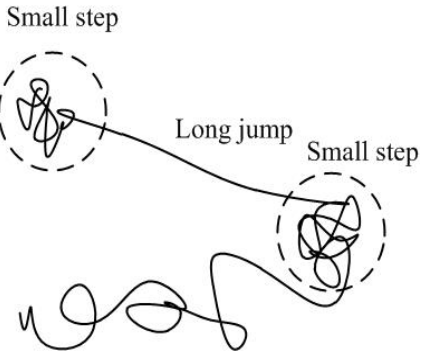
Figure 4. Trajectory of Levy flight.